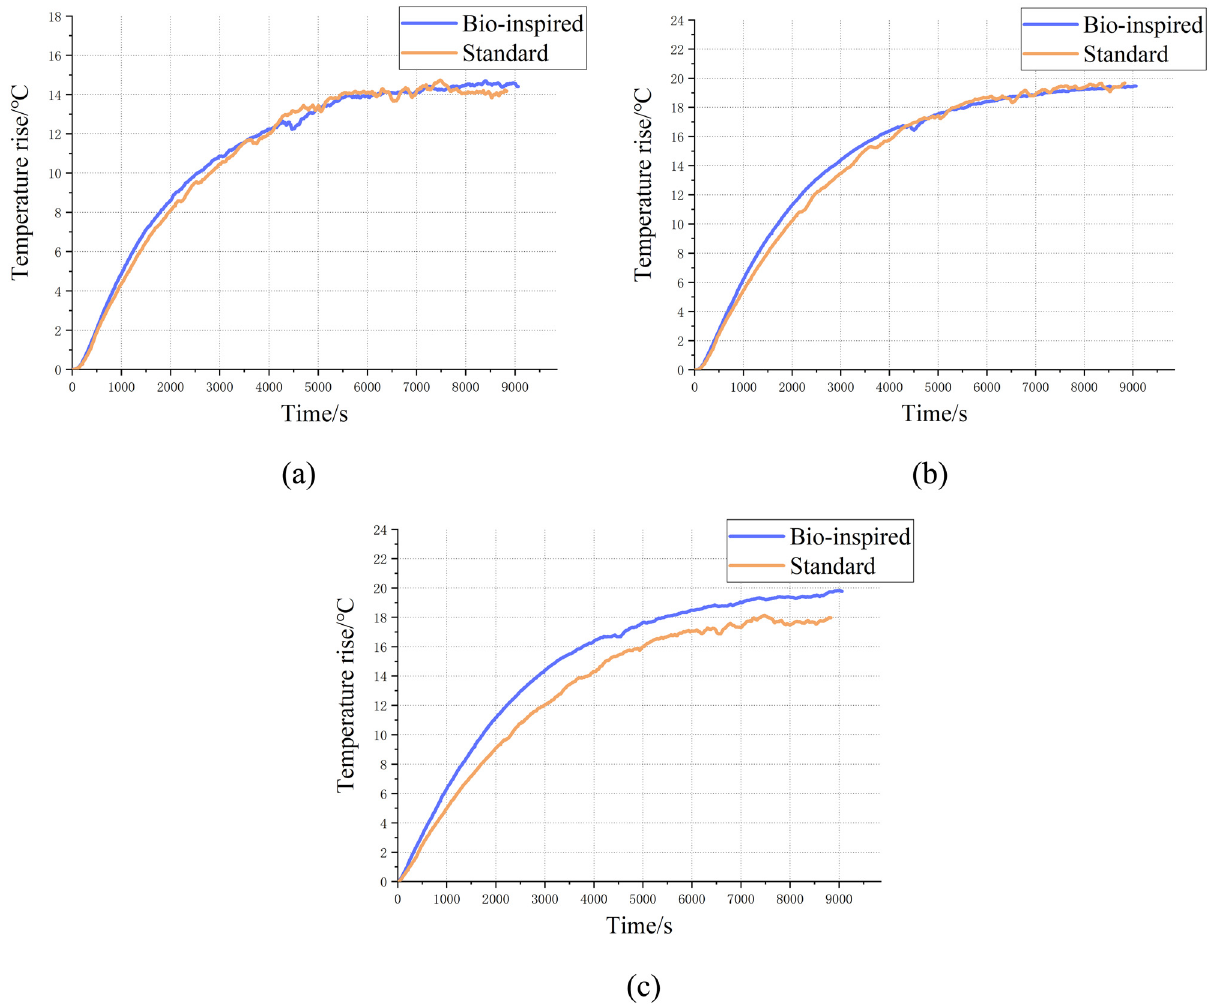
Figure 9: Comparison of temperature rise at various points for the 22 V supply voltage: ( a ) point T1; ( b ) point T2; ( c ) point